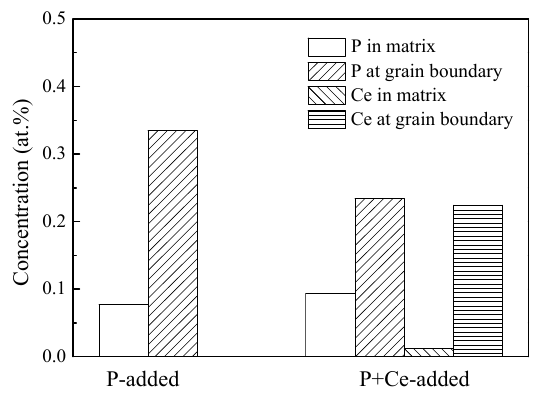
Figure 8. Grain boundary concentrations of P and Ce in the P ‐ added and P+Ce ‐ added specimens tested at 800 °C, determined by FE ‐ STEM microanalysis.